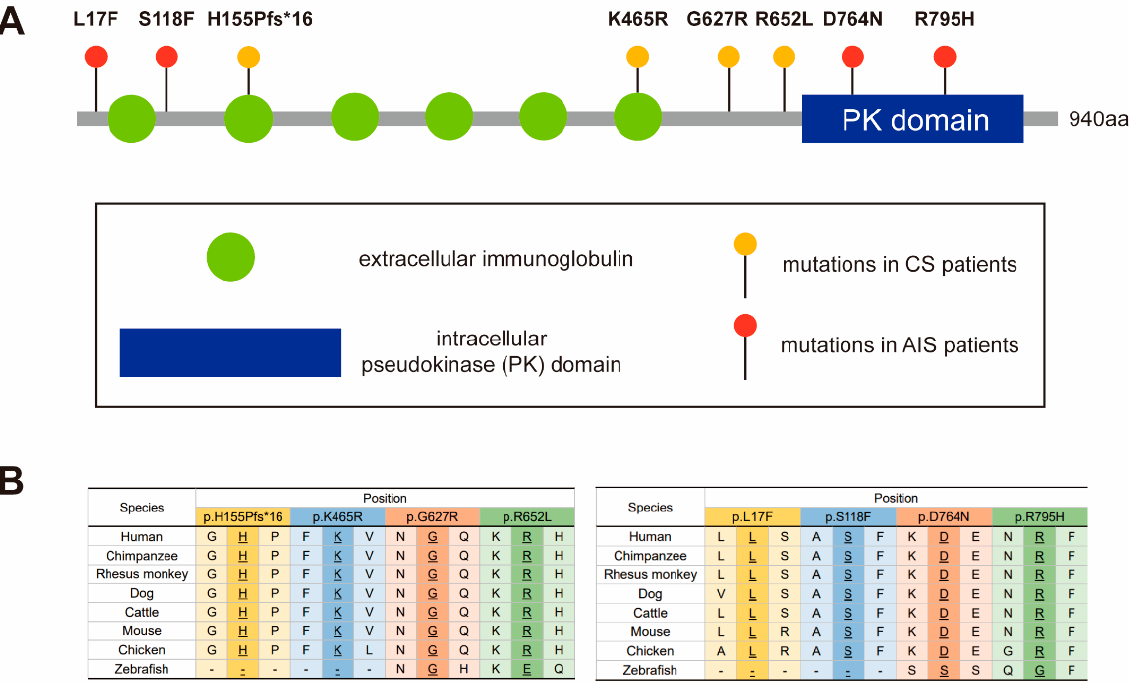
Figure 1. Mapping and conservation analysis of the identified variants. ( A ) Mapping of eight PTK7 variants revealed that p.L17F, p.S118F, p.H155Pfs*16 and p.K465R are located in the extracellular region of PTK7 protein. p.D764N and p.R795H are located in the intracellular pseudokinase domain. ( B ) The conservation of variants in human and other vertebrate species.